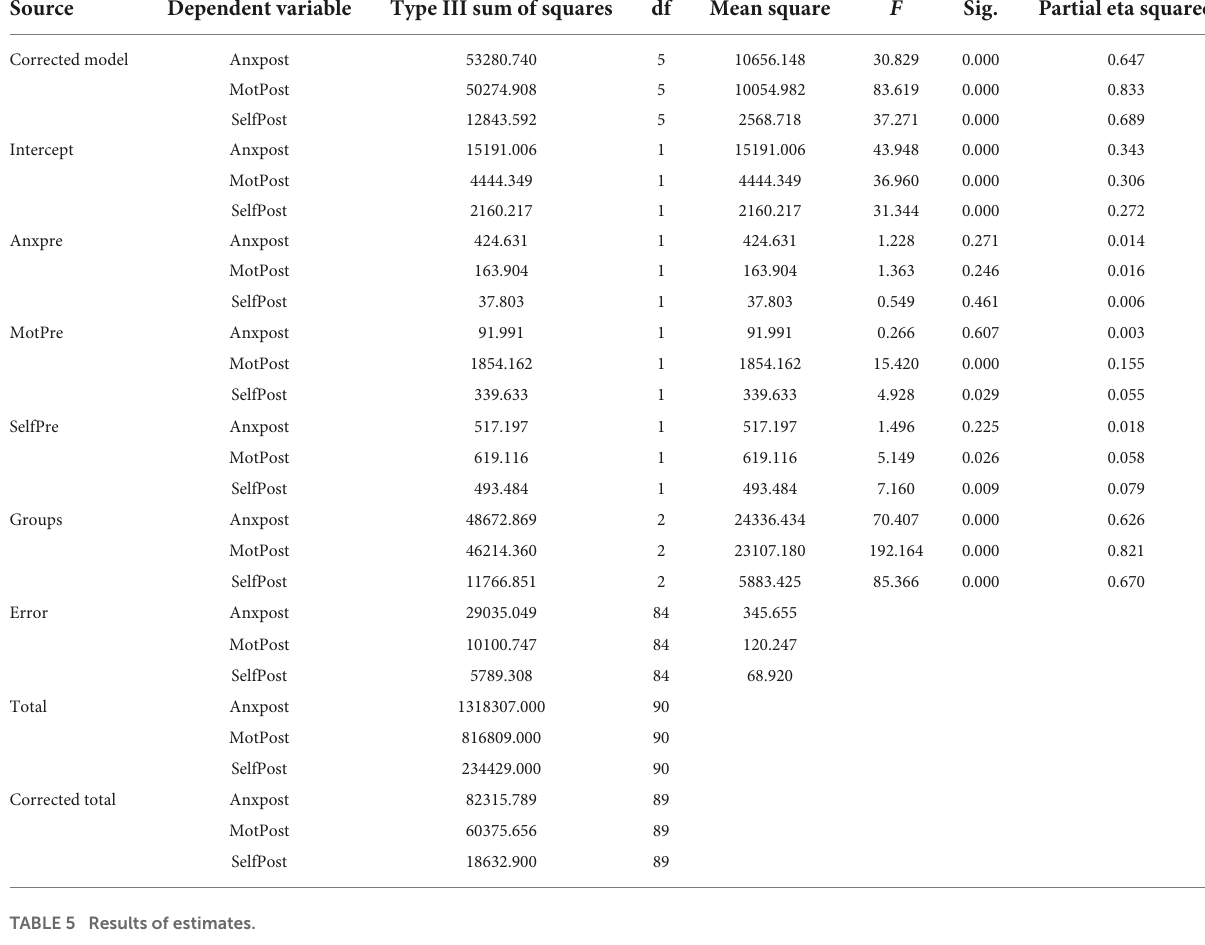
TABLE 4 Results tests of between-subjects effects.